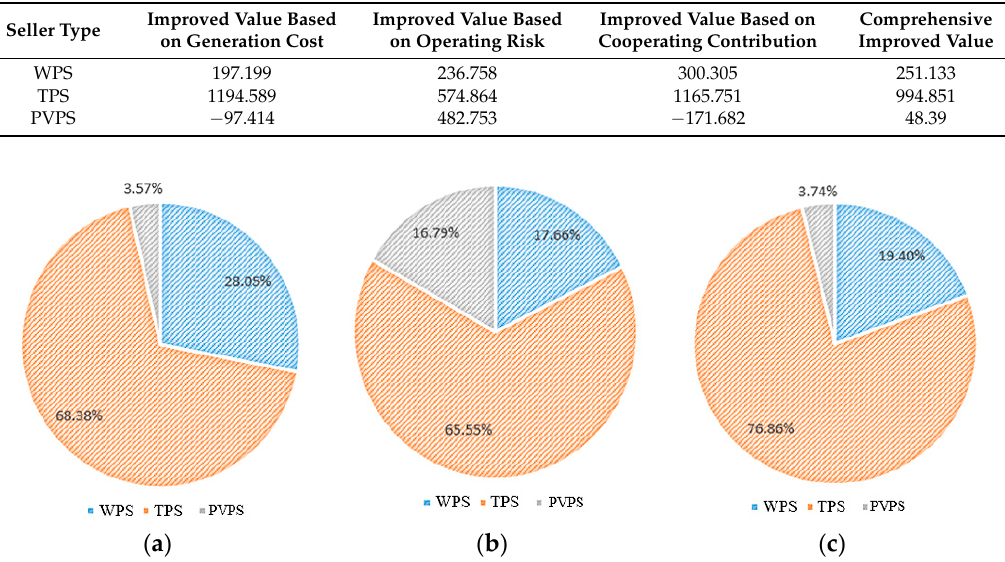
Table 9. Income distribution results based on the improved Shapley value method.